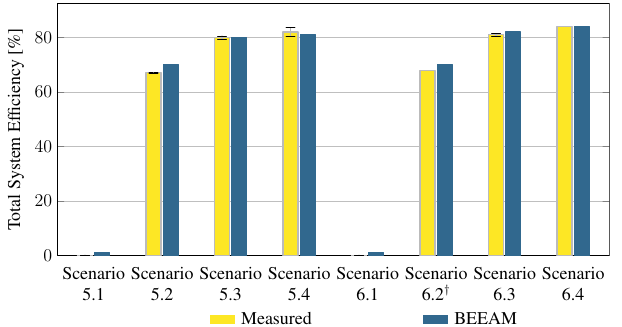
Figure 19. Predicted versus measured total system efficiencies, Scenarios 5 and 6. † indicates that uncertainty could not be estimated; see Appendix A.4.